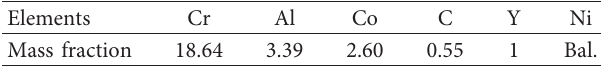
Table 2: Chemical constituents of NiCoCrAlY